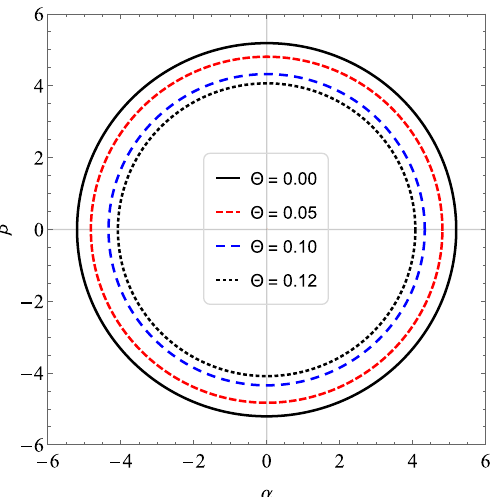
Figure 6. We see the influence of non-commutativity in the shadow admitting M = 1 and (cid:31) and